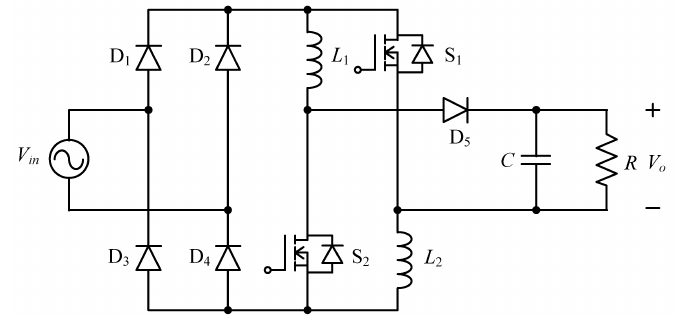
Figure 1. The conventional high step-up voltage gain PFC converter.